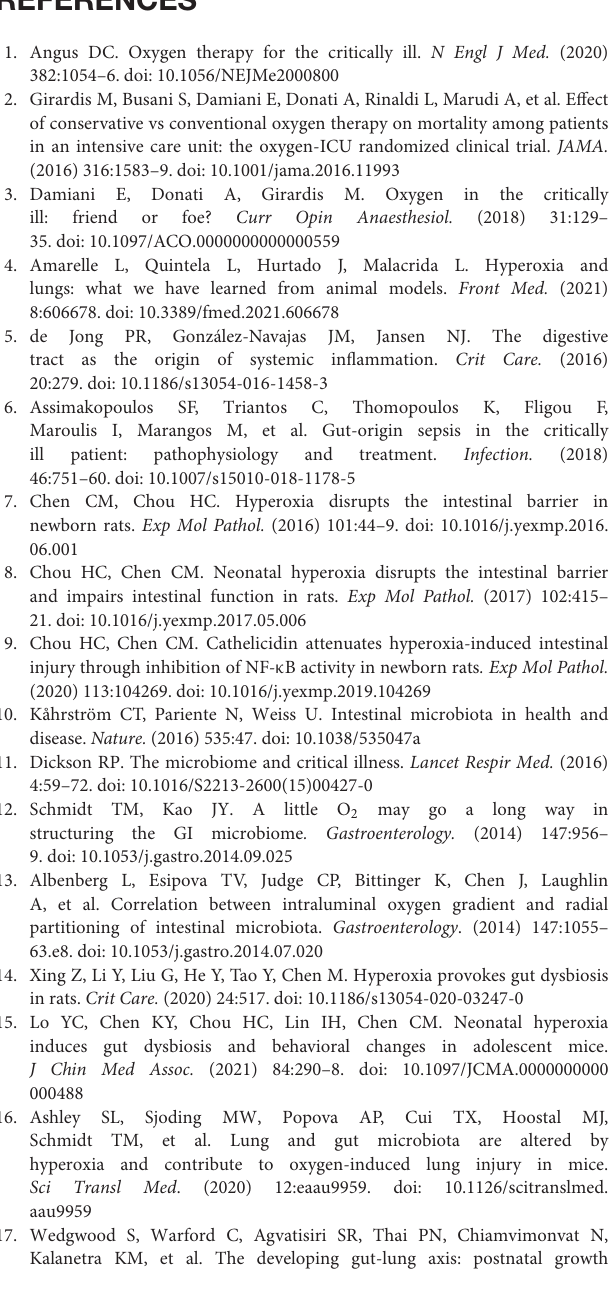
Supplementary Table 1 | ANOVA or non-parametric analysis of time- and dose-dependent gut histopathological injury induced by hyperoxia.